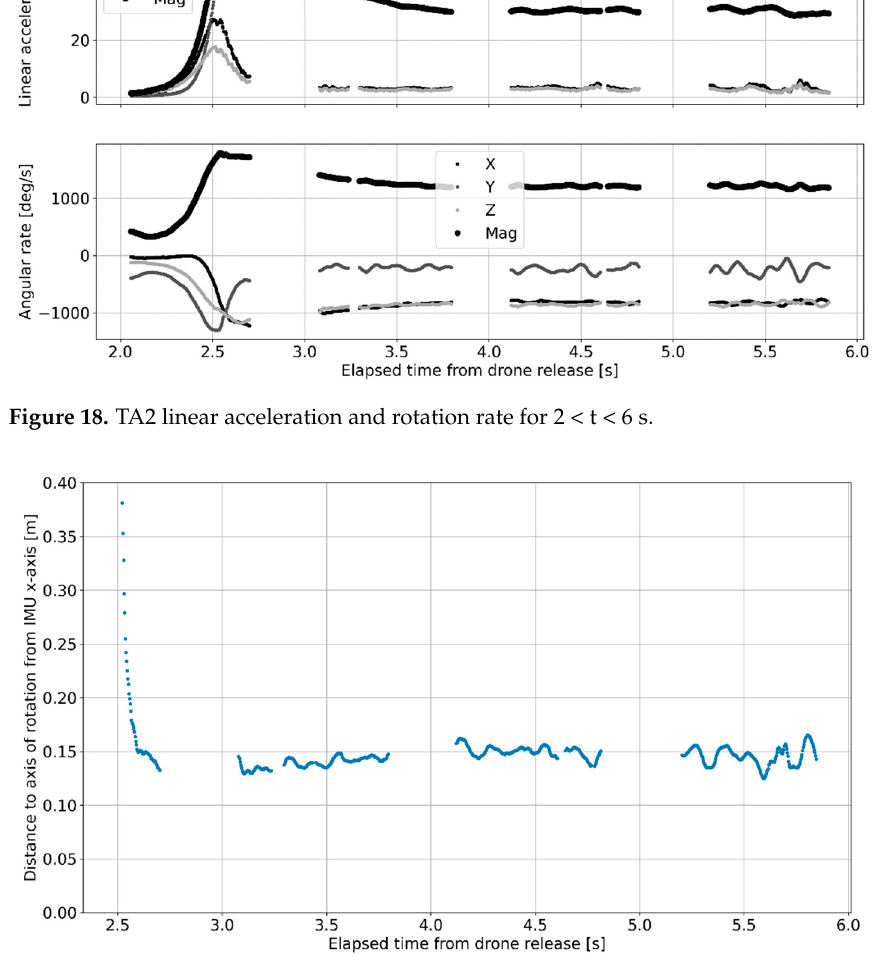
Figure 21. TA2 linear acceleration and rotation rate for complete flight, 0 < t < 15.7 s.